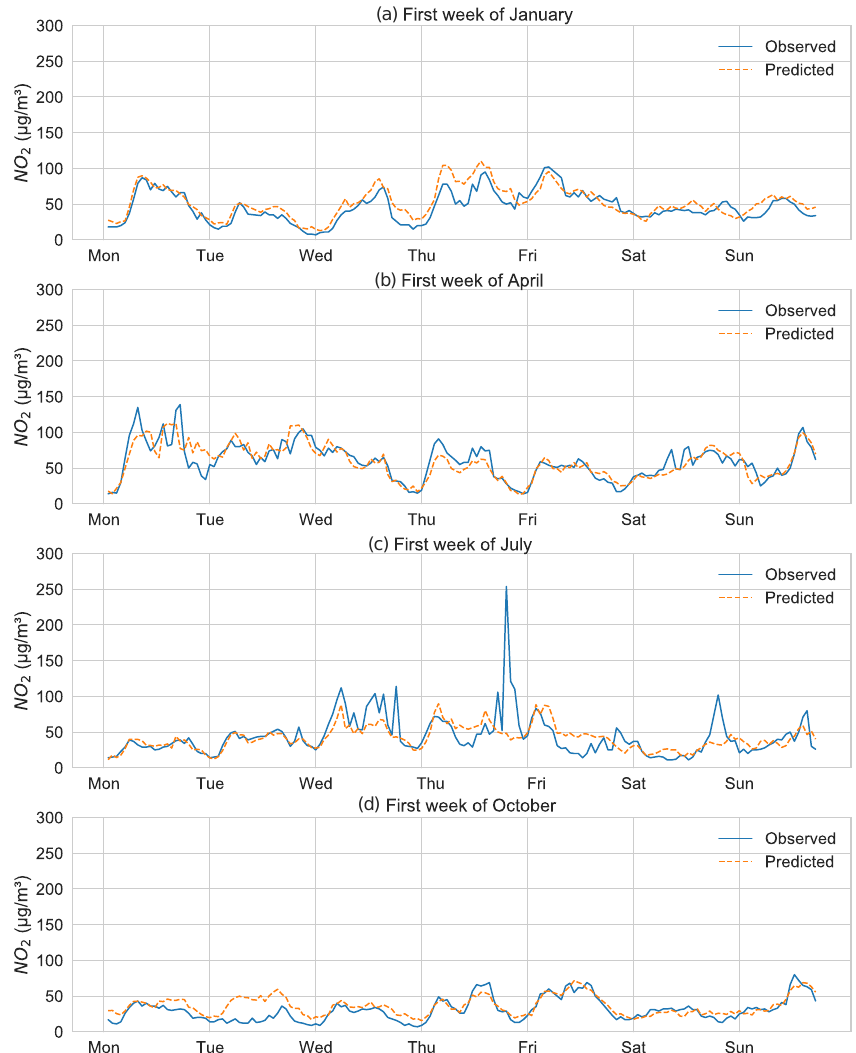
Figure 6. Prediction of the model vs. observed values for the first week (Monday to Sunday) of each quarter in 2017.